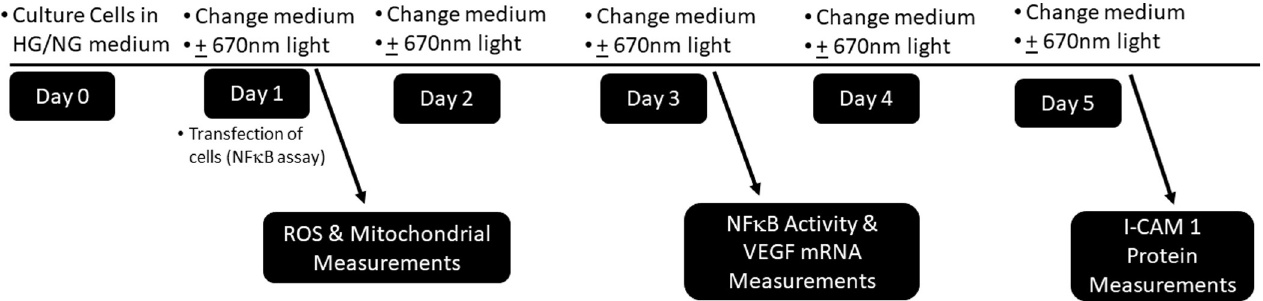
Fig 1. Culture and treatment flow chart. All cells were cultured for experimental on day 0. Cells were treated at each indicated time point and assayed 1 hour after treatment with 670nm light.